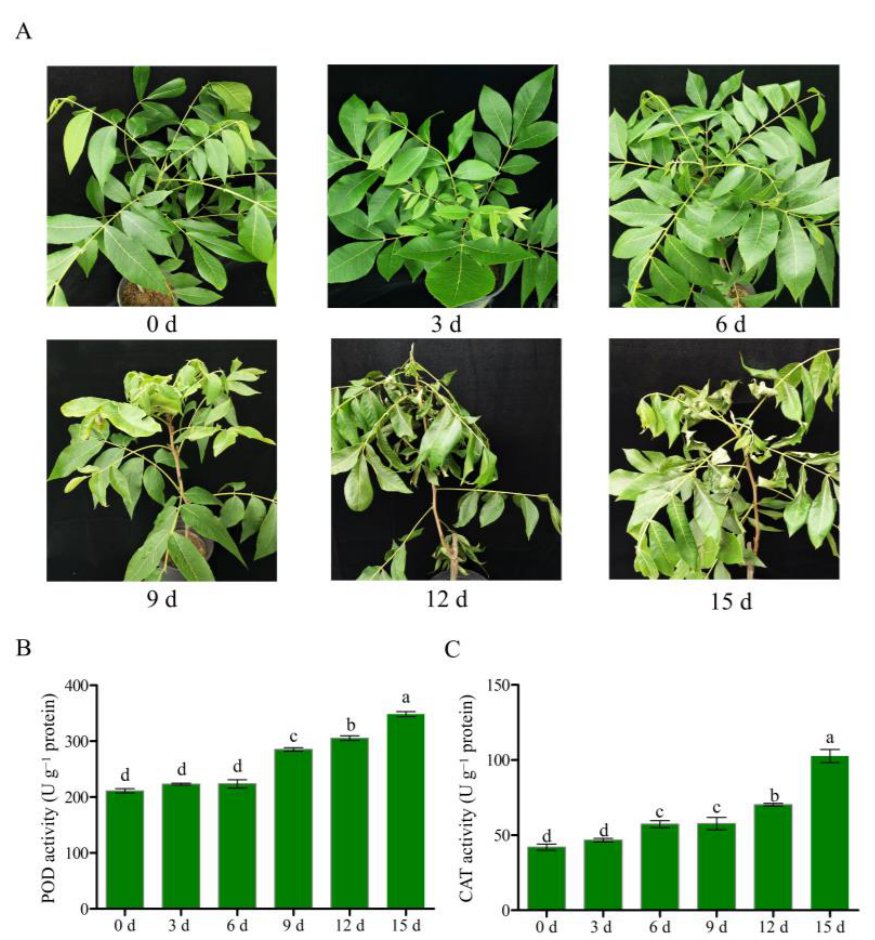
Figure 1. Drought treatment affected the growth of pecan seedlings and the activities of antioxidant enzymes. ( A ) The phenotype of pecan seedlings under drought stress. POD ( B ) and CAT ( C ) activities in pecan seedlings in response to drought. Lowercase letters represent significant differences ( p < 0.05) according to Duncan’s multiple range test. Error bars indicate the means ± SEs obtained from three biological replicates.